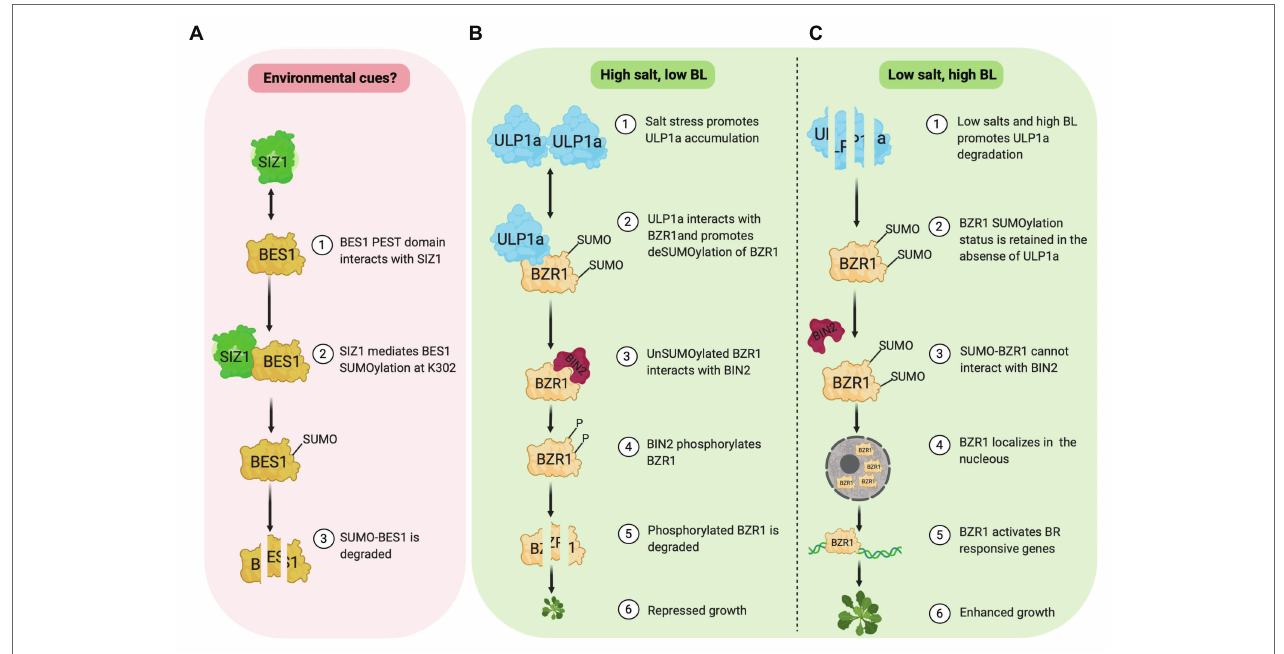
FIGURE 1 | SUMOylation of BES1 (pink box) and BZR1 (green box). (A) E3 ligase, SIZ1, mediates SUMOylation of BES1 at K302, which promotes BES1 degradation. (B) Under salt stress, ULP1a SUMO protease catalyzes deSUMOylation of BZR1 and BIN2 phosphorylates non-SUMOylated BZR1, which leads to BZR1 degradation. (C) Under non-salt stress condition, SUMO-BZR1 is stable and localizes in the nucleus to activate BR responsive